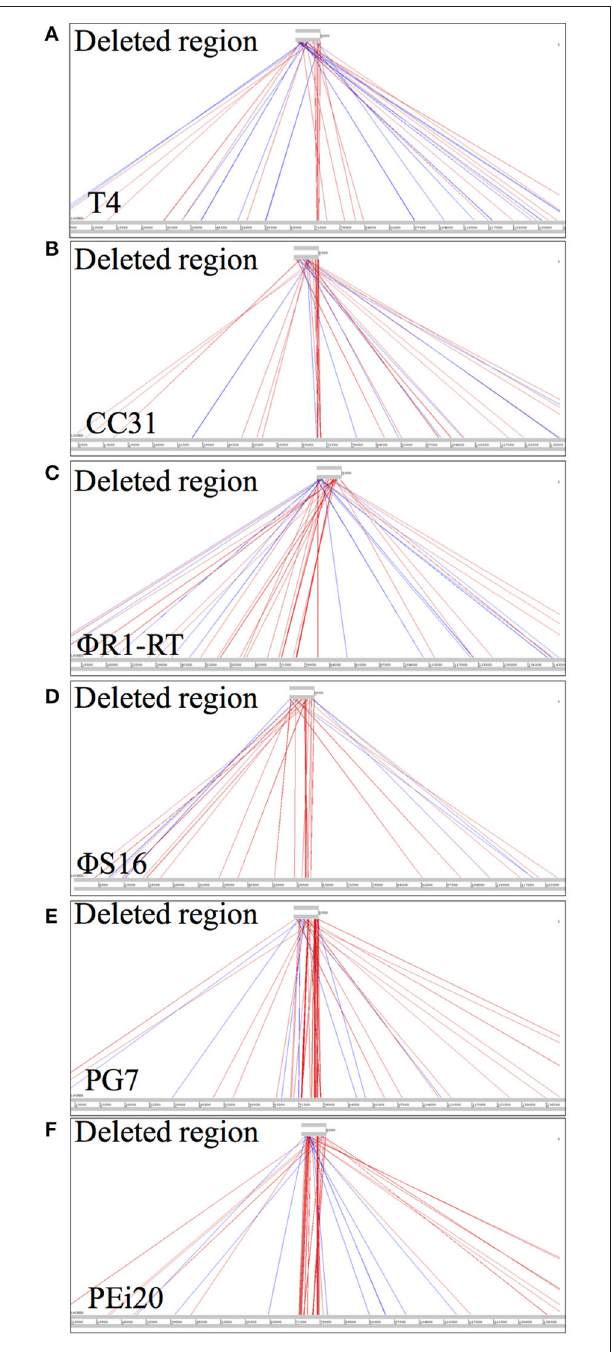
FIGURE 5 | DNA sequence comparisons of the smallest deleted region in 8 CBH8o (6.5kb) with other T4-like phages, using ACT. (A) Comparison with phage T4. (B) Comparison with CC31. (C) Comparison with 8 R1-RT. (D) Comparison with 8 S16. (E) Comparison with PG7. (F) Comparison with